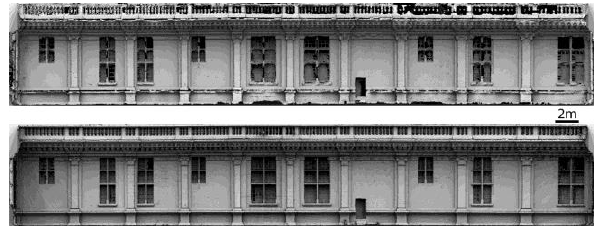
Figure 9: 3D reconstruction differences between standard cartographic method and fully automated geometry image method (shaded relief images on TS)